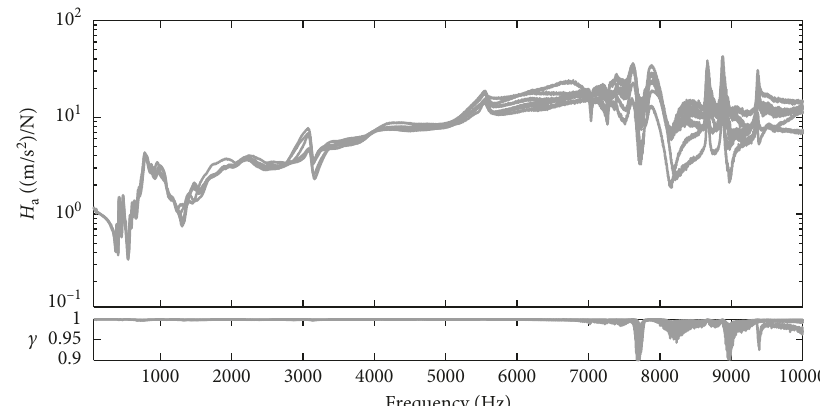
Figure 6: Assembly reproducibility analysis from seven experimental FRFs for transversal excitation ( z direction) and response mea- surement at point E1 ( z direction).